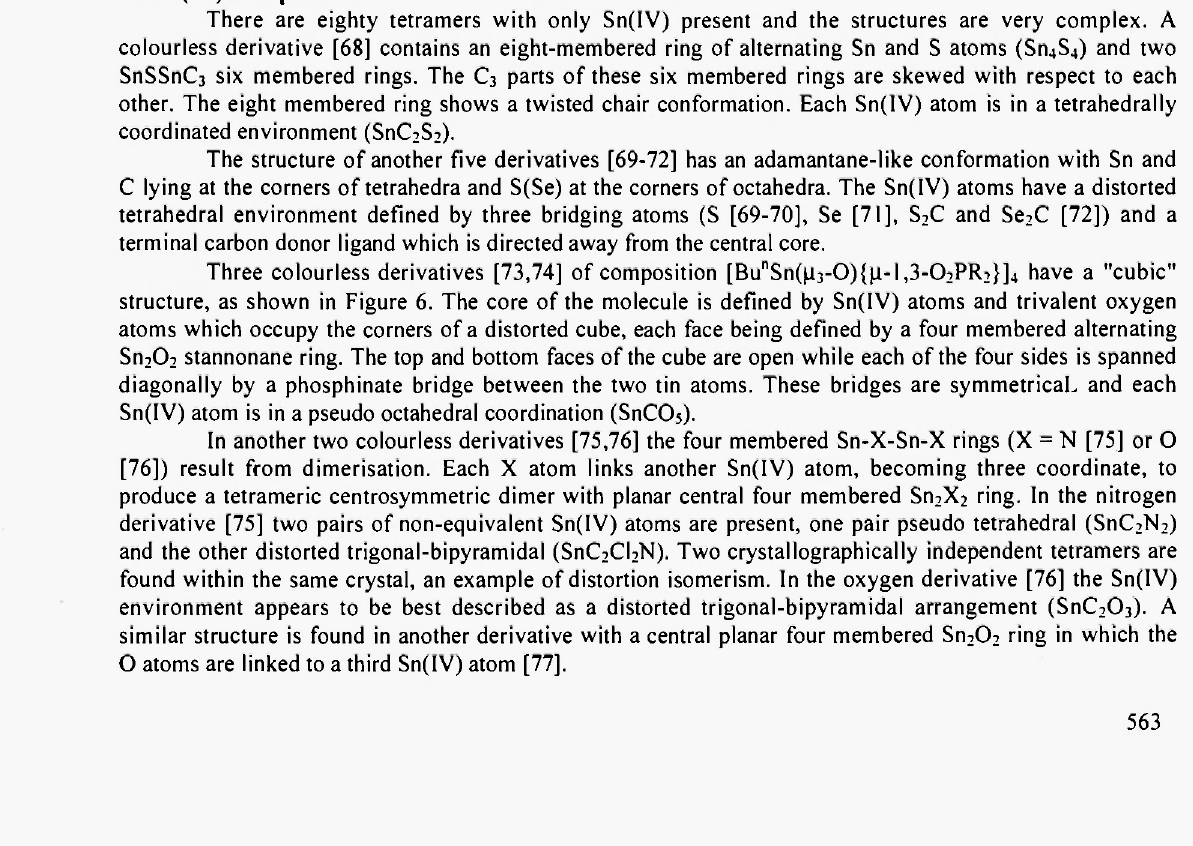
Fig. 5. Structure of [(Ph 3 Sn)3Sn(N0 3 )|